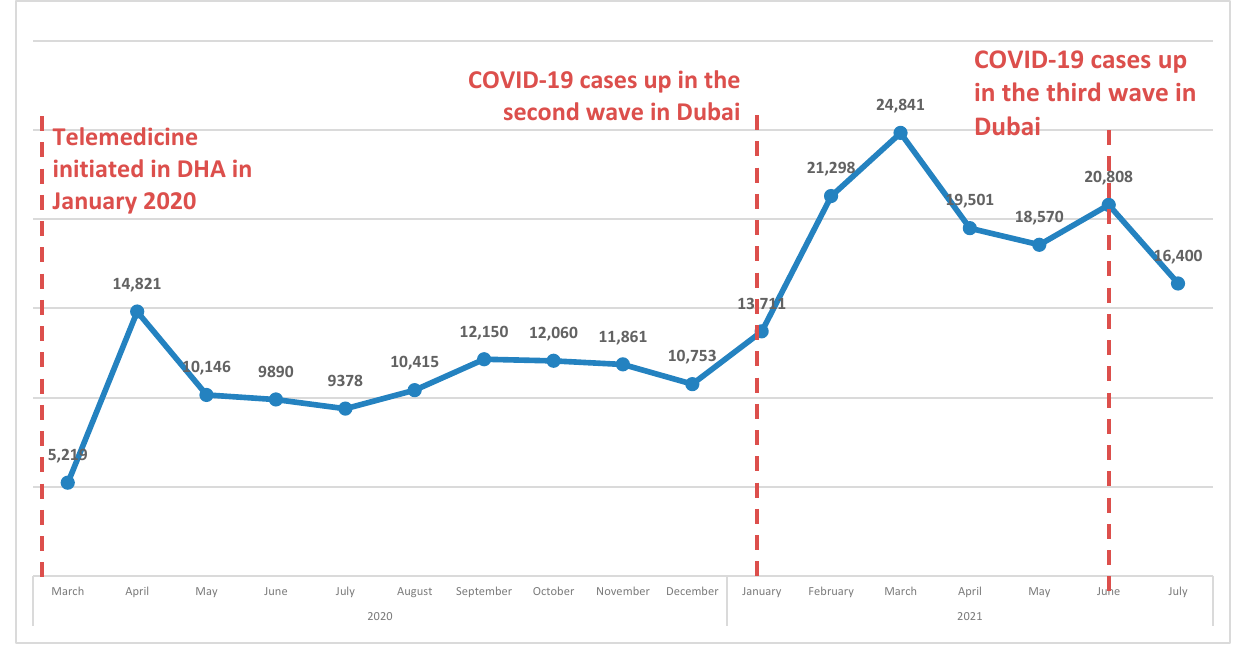
Figure 3. Trend/timeline of monthly telehealth utilization during the COVID-19 pandemic from Table 4. Binary logistic regression analysis for the factors associated with turnaround time for